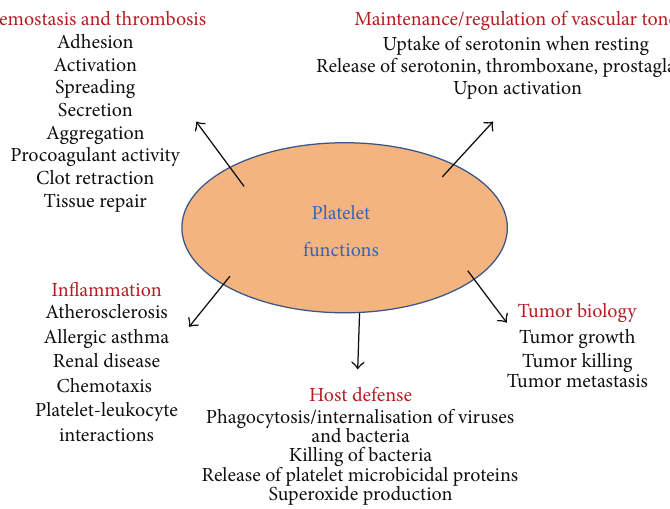
Figure 8: The multifunctional platelet (adapted from Harrison, 2005